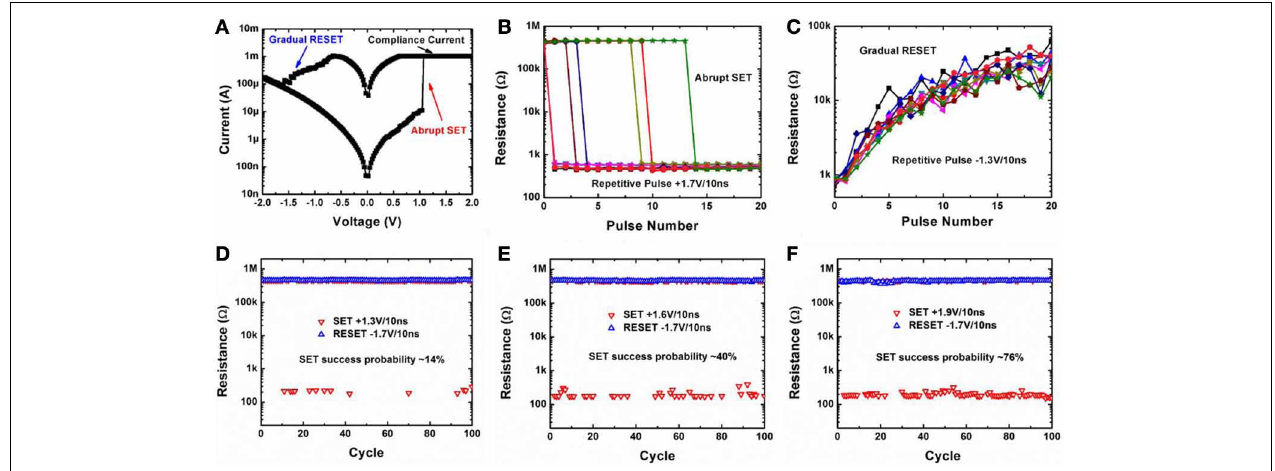
FIGURE 2 | (A) Measured DC I-V switching characteristics of the oxide synaptic device. Abrupt SET transition and gradual RESET transition is observed. (B) Measured abrupt SET transition starting from the off-state ( ∼ 500k (cid:2) ) by repetitive SET pulses ( + 1.7V/10ns), in which case the device functions as a binary synapse. (C) Measured gradual RESET transition starting from the on-state ( ∼ 500 (cid:2) ) by repetitive RESET pulses ( − 1.3V/10ns), in which case the device functions as an analog synapse. Results from 10